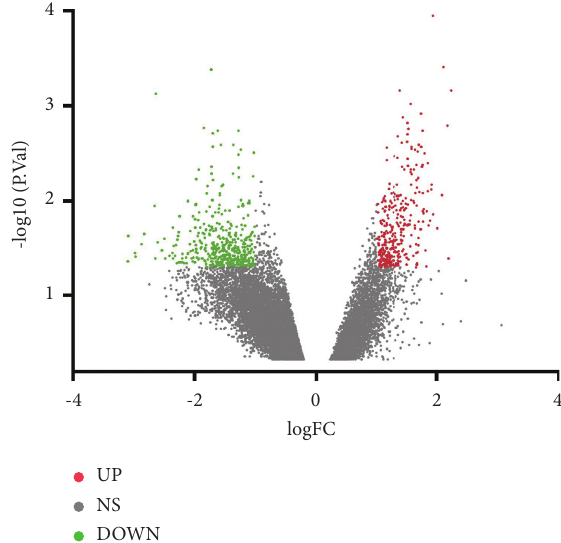
Figure 1: Volcano maps of all DEGs. Red represents upregulated genes, green represents downregulated genes, and gray represents genes that are not differentially expressed.